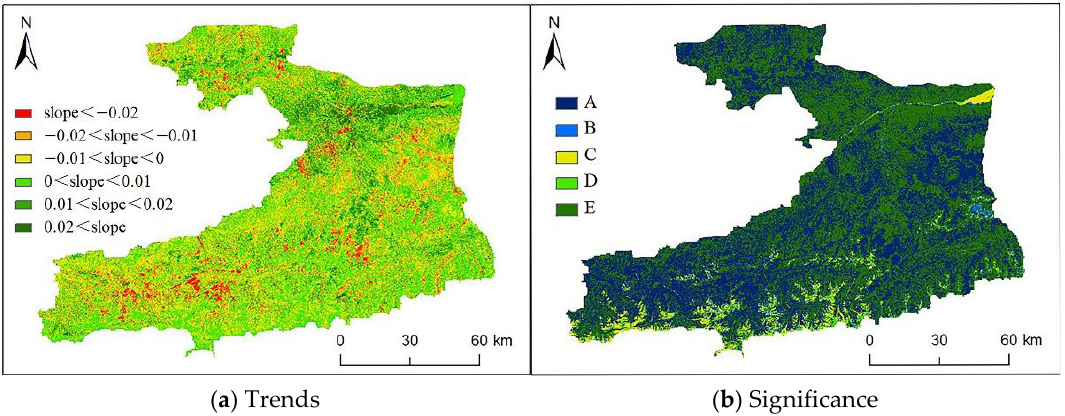
Figure 9. Trends ( a ) and significance ( b ) of vegetation cover changes in the western Tian Shan region in the last 15 years, where A is a extremely significant decrease; B is a significant decrease; C is no significant change; D is a significant increase; and E is a significant increase. This is the same in Table 2. Table 2. Vegetation cover change and significance statistics. Slope Percentage/% Significance Percentage/% Slope < − 0.02 3.7% Extremely significant decrease 43% − 0.02 < Slope < − 0.01 9.7% Significant decrease − 0.01 < Slope < 0 0 < Slope < 0.01